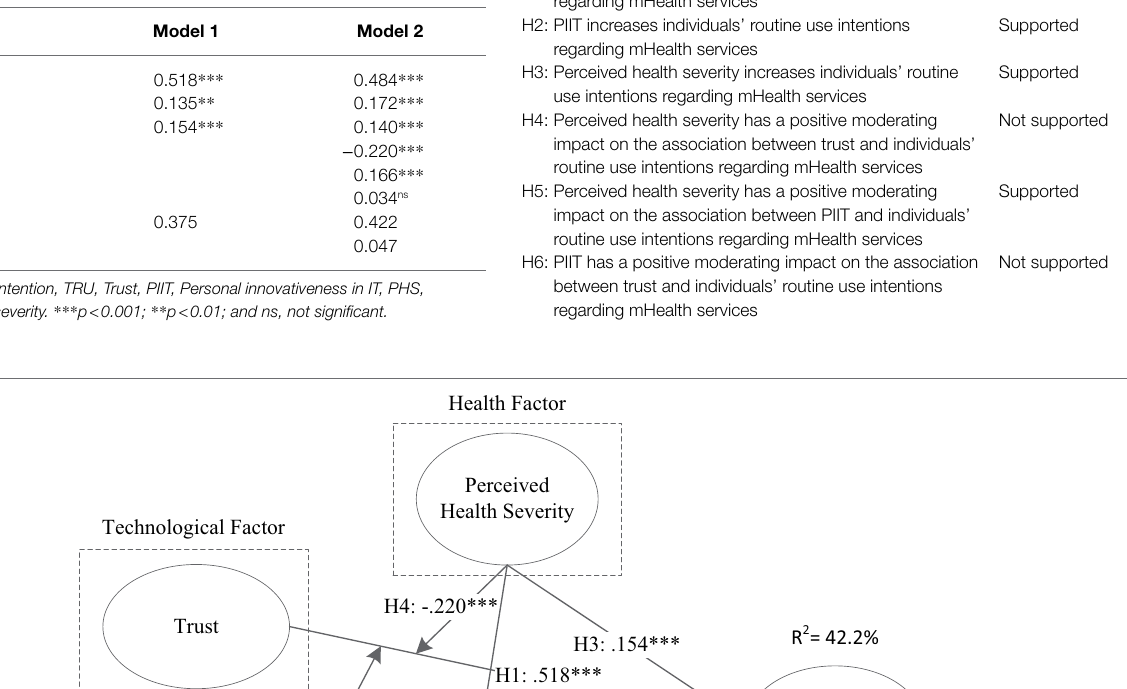
TABLE 5 | The results of the structural equation model (SEM).